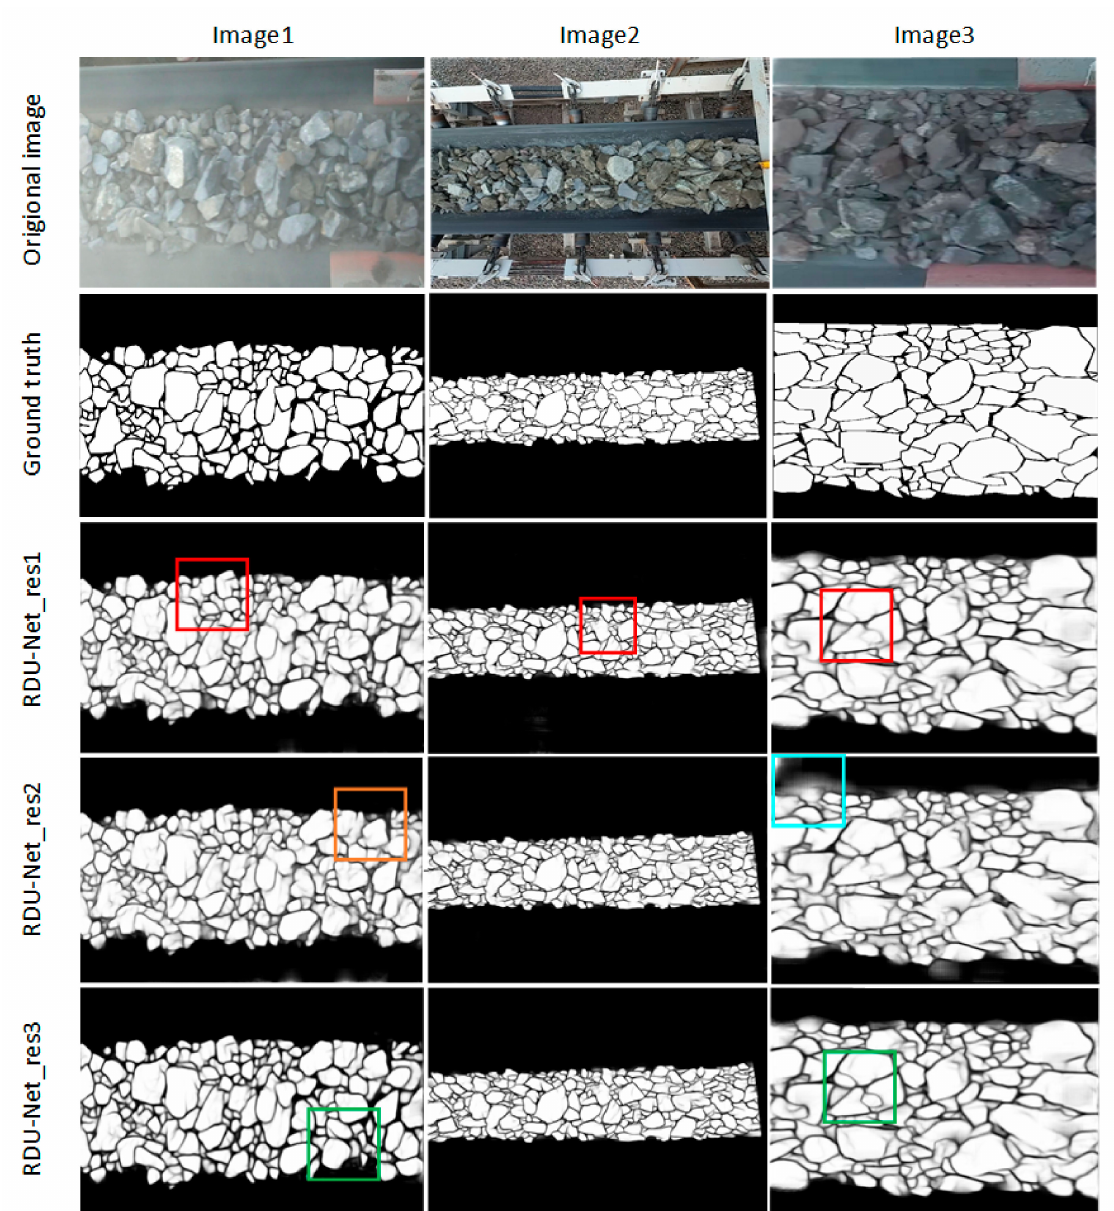
Figure 8. Comparison of model segmentation results with residual structure added at di ff erent positions. Red box: under segmentation; Orange Box: over segmentation; Blue box: wrong identification of conveyor belt; Green box: good